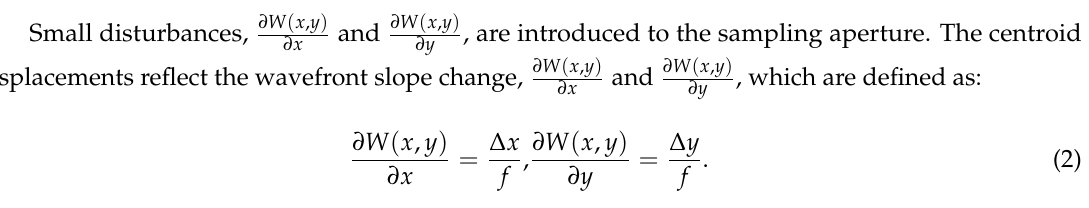
Figure 4. Schematic diagram of the wavefront sensor.